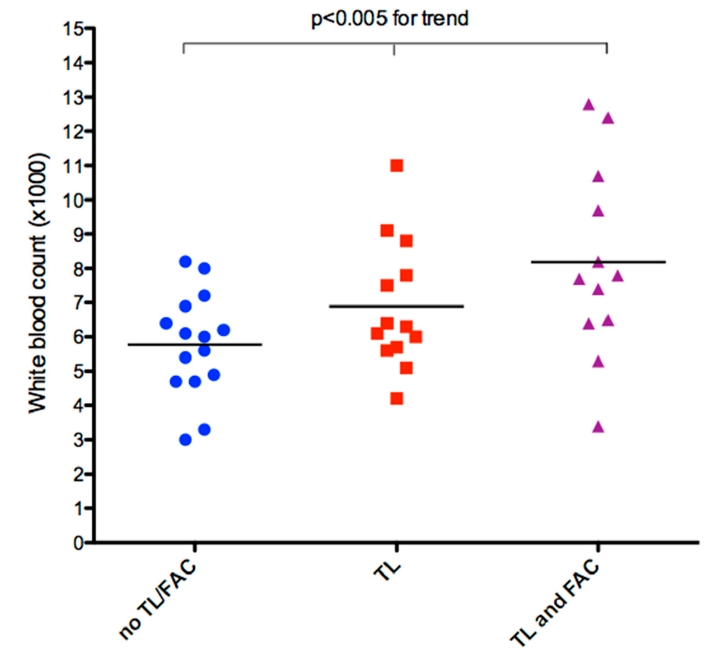
Figure 4. Individual value bar graph of WBC count versus lead fibrosis. There is a